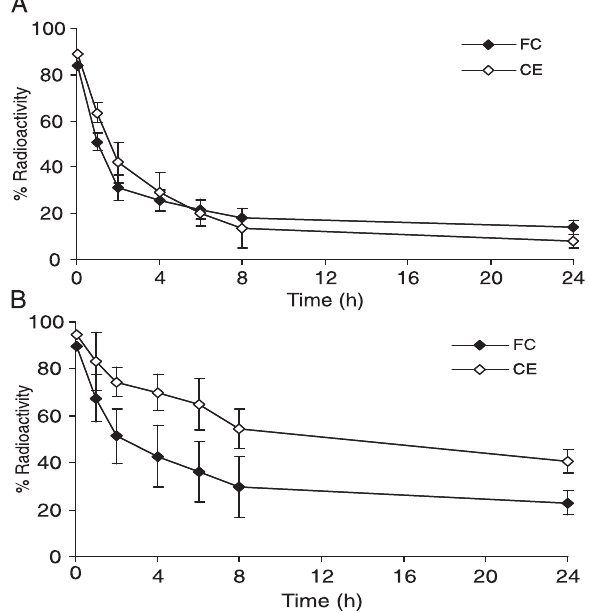
Figure 1. Plasma decay curves of the artificial nanoemulsion 3 H–free cholesterol (FC) and 14 C–cholesteryl esters (CE). A, Control group (N = 8); B, cholesterol-fed group (N = 6). The artificial labeled nanoemulsion was injected into the marginal ear vein of rabbits after 8 weeks feeding of a regular or an athero- genic diet. Plasma samples were obtained at intervals over 24 h for counting of the radioactivity in a liquid scintillation solution. Data are reported as mean ±